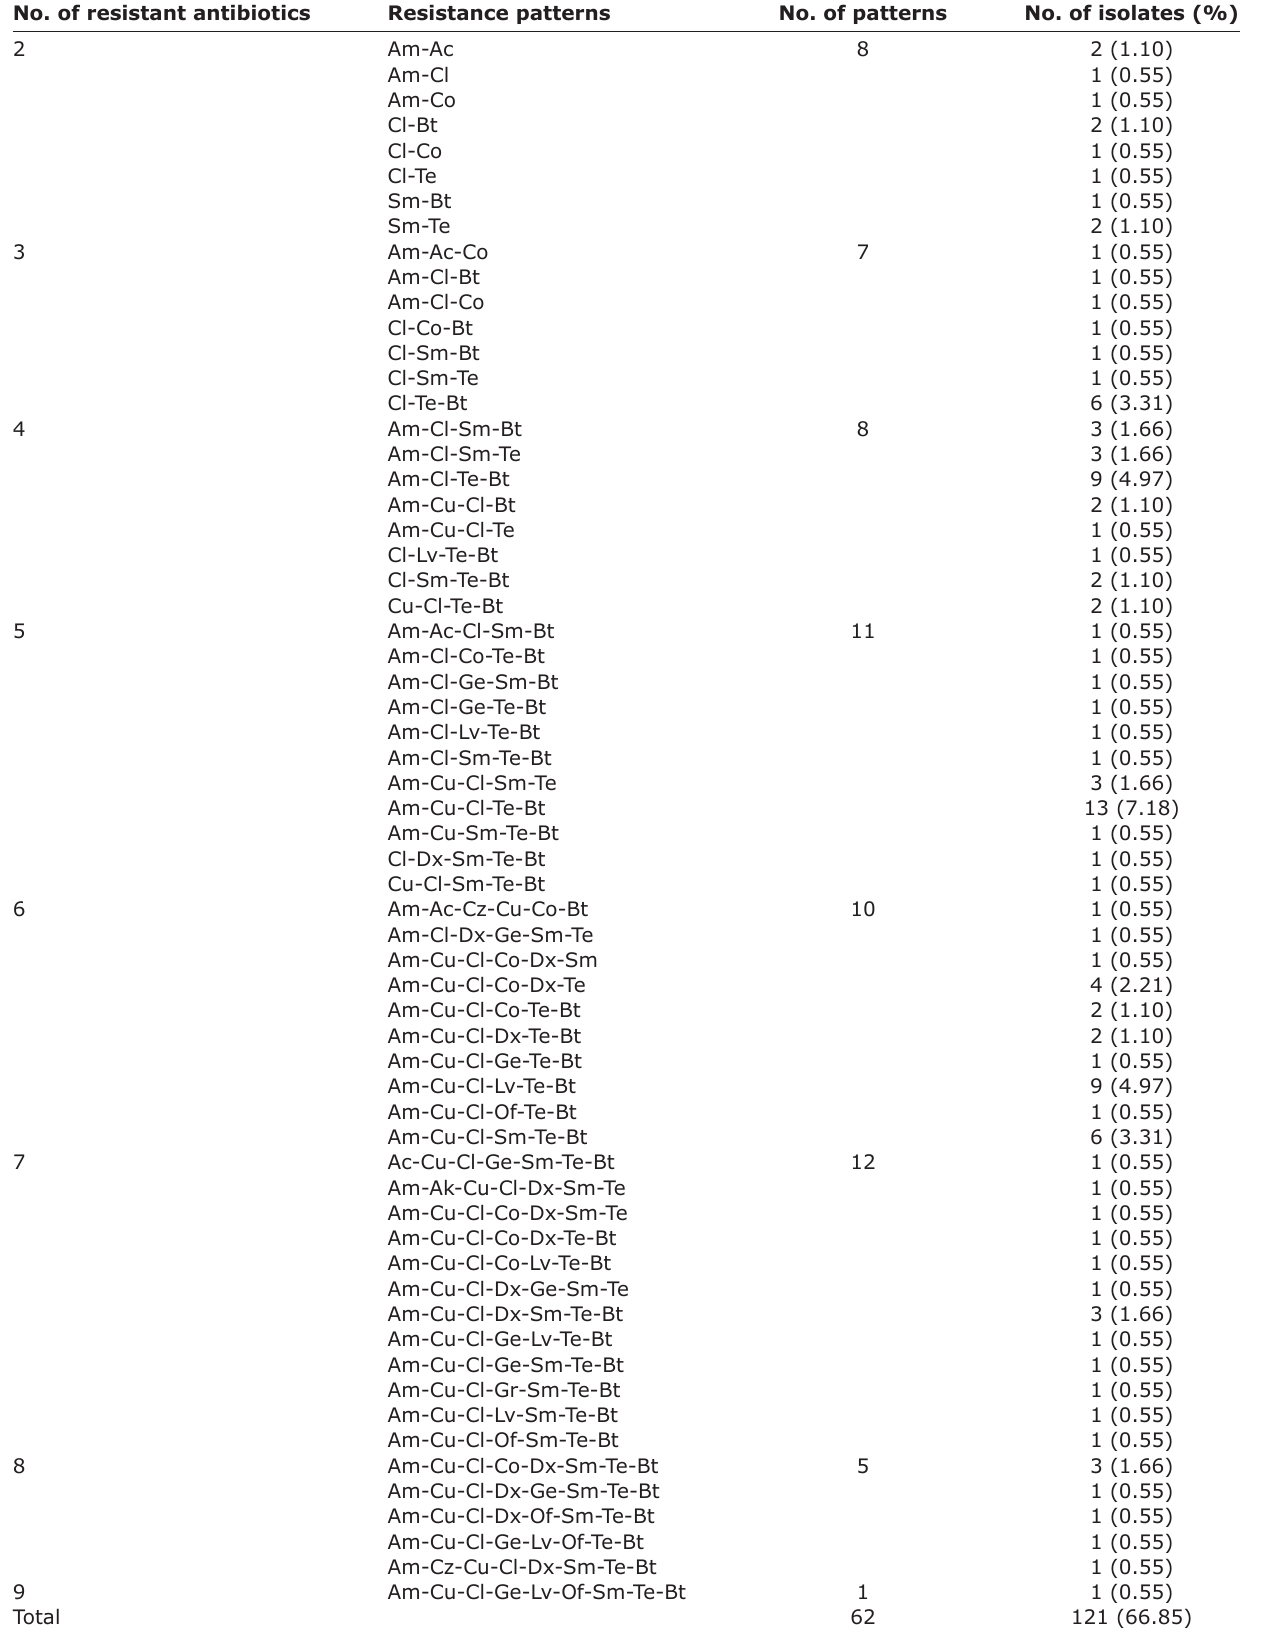
Table-5: The multiple antibiotic resistance patterns of Salmonella isolated in the poultry farms and households (n=181). No. of resistant